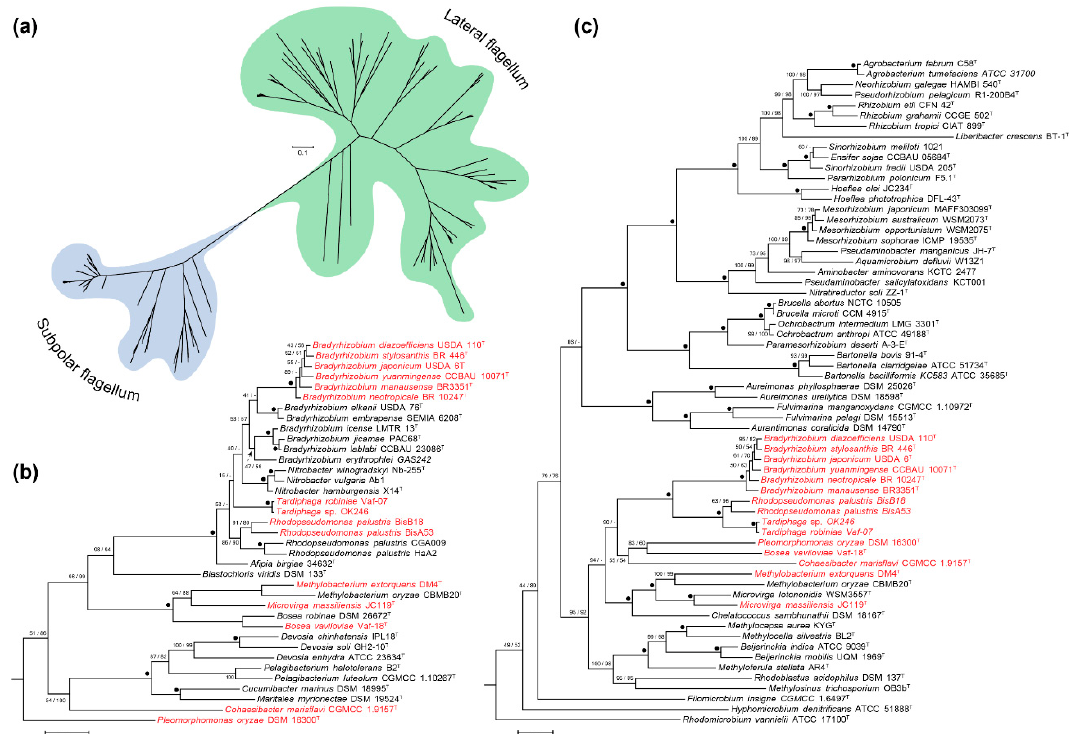
Figure 5. ML tree analysis of the subpolar and lateral flagellar systems across representative Rhizobiales genomes based on the concatenated sequences of 13 orthologous amino acid sequences, common to both flagella. Bootstrap values under ML and MP are indicated above branches. Dots indicate maximum support under all settings. ( a ) Subpolar and lateral flagellar clusters in unrooted tree. ( b ) Subpolar and ( c ) lateral flagellar system cluster trees were rooted using the other flagellar cluster as outgroup. Genomes harboring both flagellar systems are emphasized in red typing. Bold and T indicate type strain.